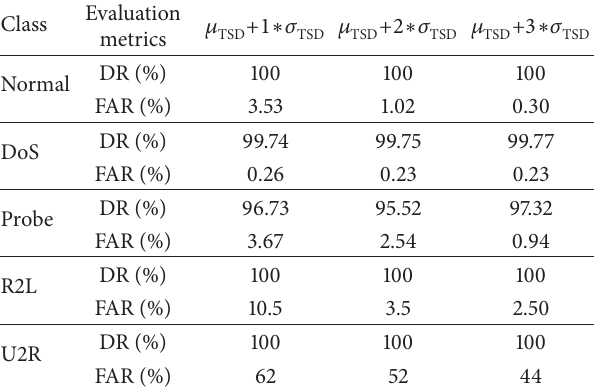
Table 6: Testing performances for five classes.